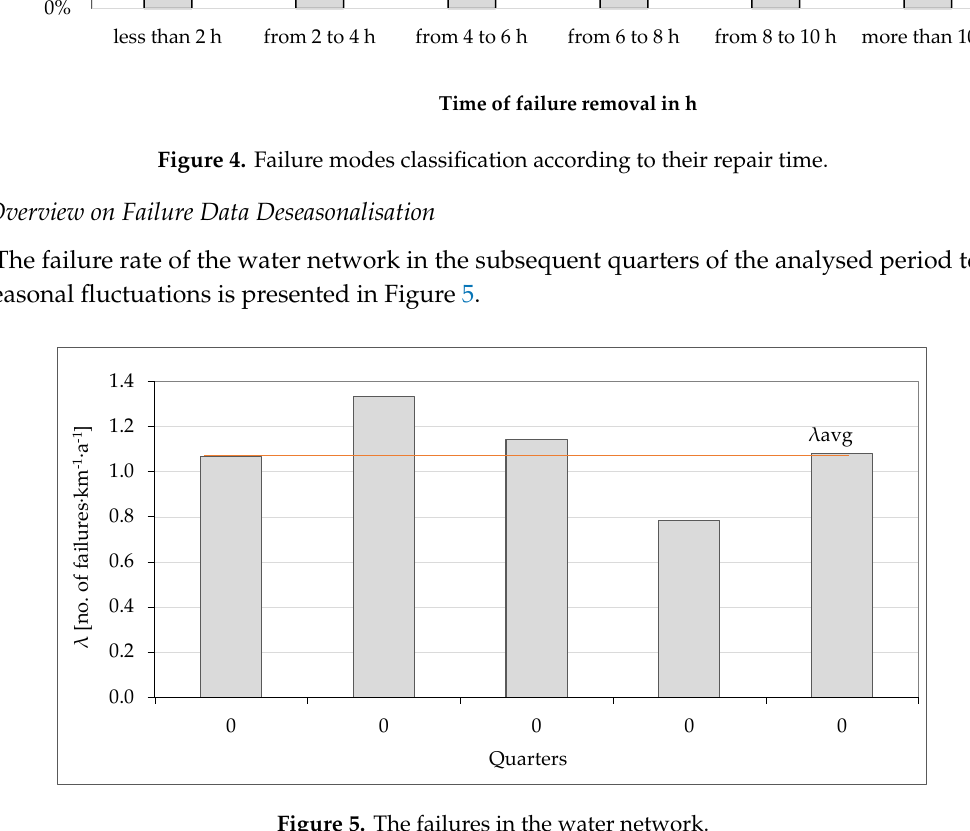
Figure 5. The failures in the water network.